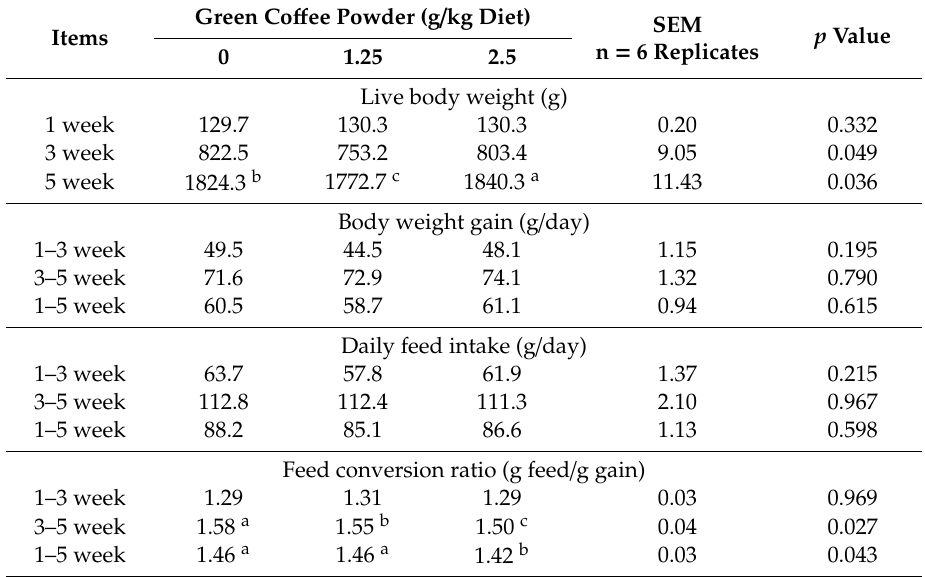
Table 2. Growth performance parameters of broiler chicks as a ff ected by graded levels of dietary green co ff ee powder